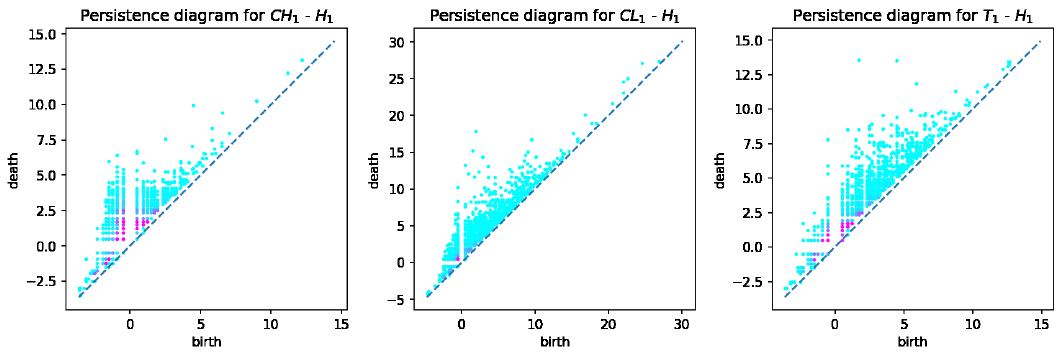
Figure 3. H 1 persistent diagrams for CH, CL, and T samples.